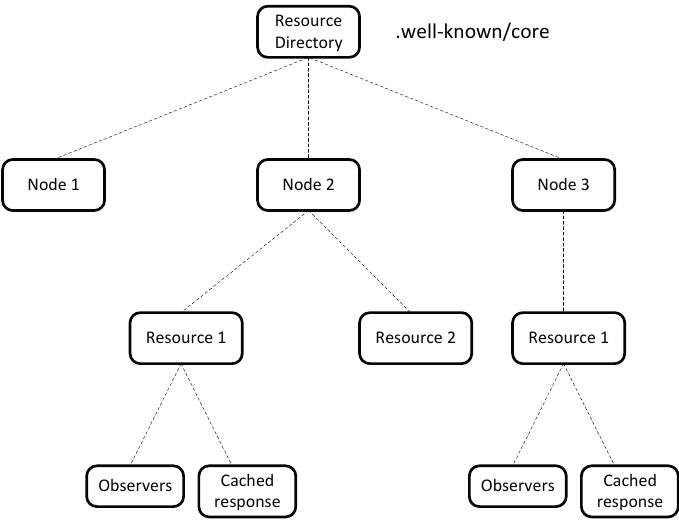
Figure 9. RD structure. The RD is designed as a tree-structure and it is indexed by the node